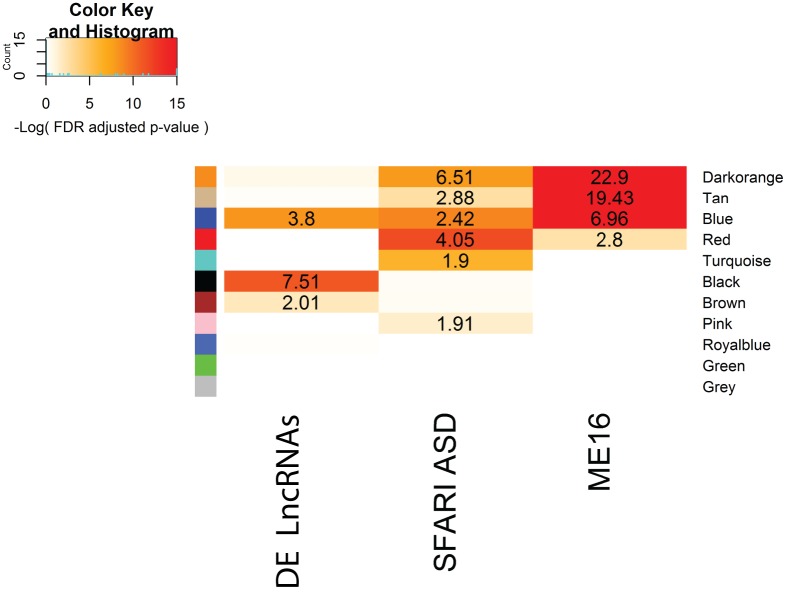
Enrichment of lncRNAs and ASD genes in brain developmental co-expression modules.The heatmap shows module-based enrichment of gene lists. “DE LncRNAs” are lncRNAs differentially expressed in the ASD cortex, “SFARI ASD” are known ASD risk genes, and “ME16” is an ASD-associated gene co-expression module identified in an independent study. Enrichment of gene lists was determined by a Fischer’s exact test requiring the FDR-adjusted p-value < 0.05 and an Odds Ratio > 1. Only modules containing at least 1 differentially expressed lncRNAs are shown.